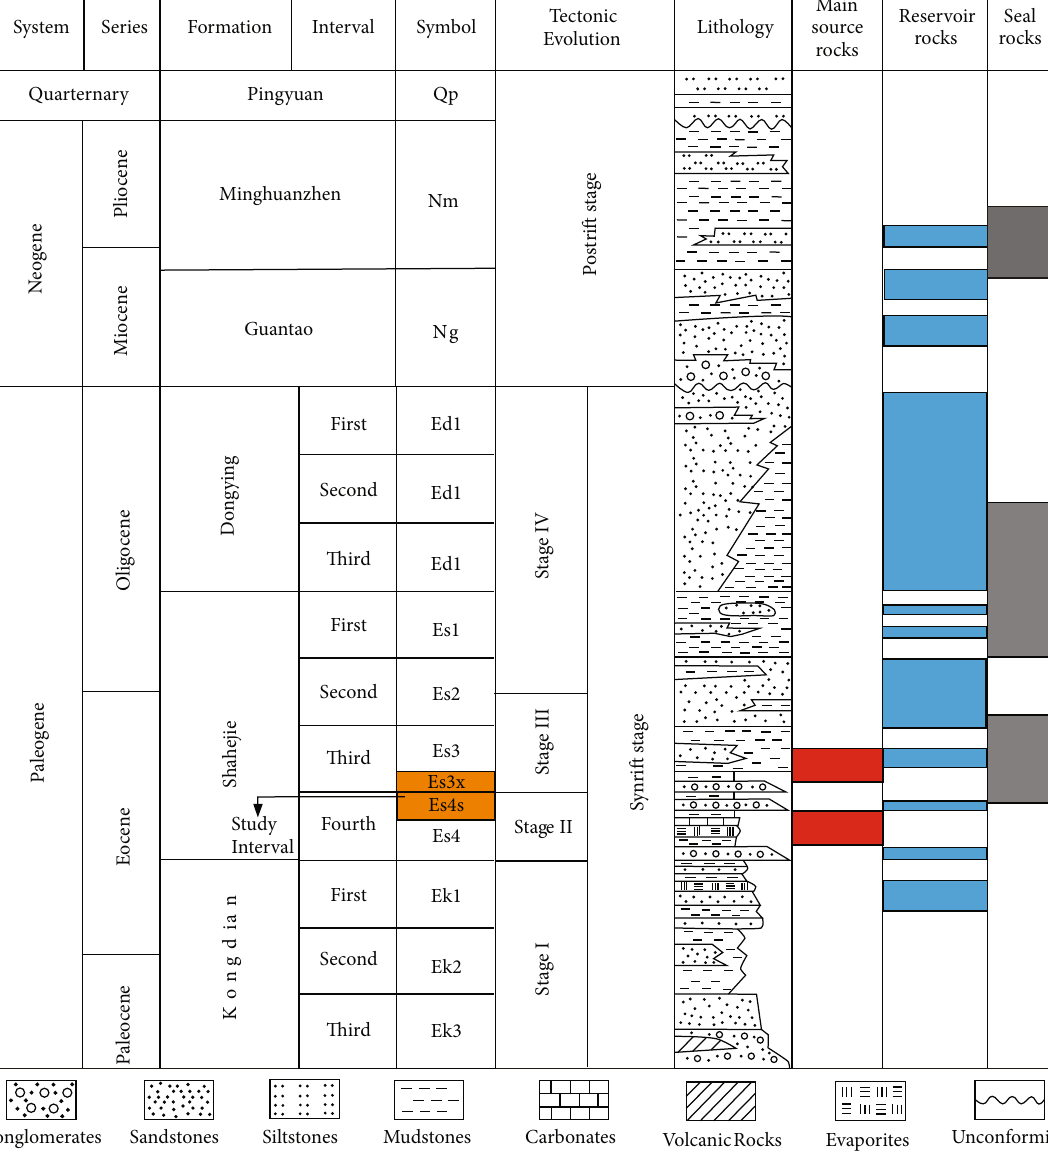
Figure 2: Stratigraphy of the Dongying depression, showing the tectonic and sedimentary evolution stages [29]. Table 1: The depth and description of